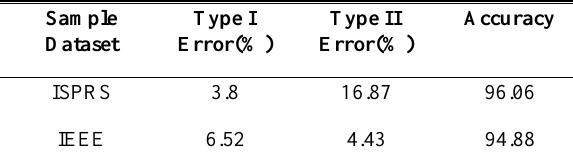
Table3. Accuracy indexes for ISPRS dataset in the SPWT algorithm.